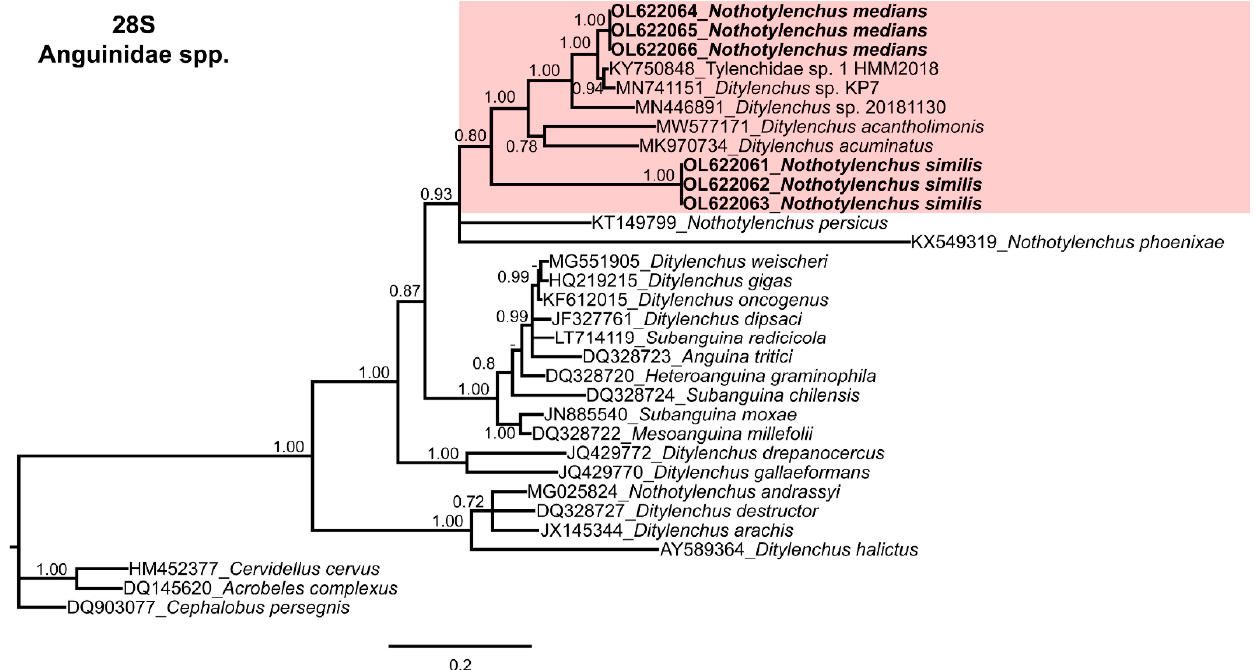
Figure 4. Phylogenetic relationships of Nothotylenchus medians and N. similis within Anguinidae. Bayesian 50% majority rule consensus tree as inferred from D2–D3 expansion domains of the 28S rRNA sequence alignment under the general time-reversible model with invariable sites and a gamma-shaped distribution (GTR + I + G). Posterior probabilities of greater than 0.70 are given for appropriate clades. The sequences produced in this study are shown in bold, and the colored box indicates the clade association of the Canadian Nothotylenchus species detected in this study.